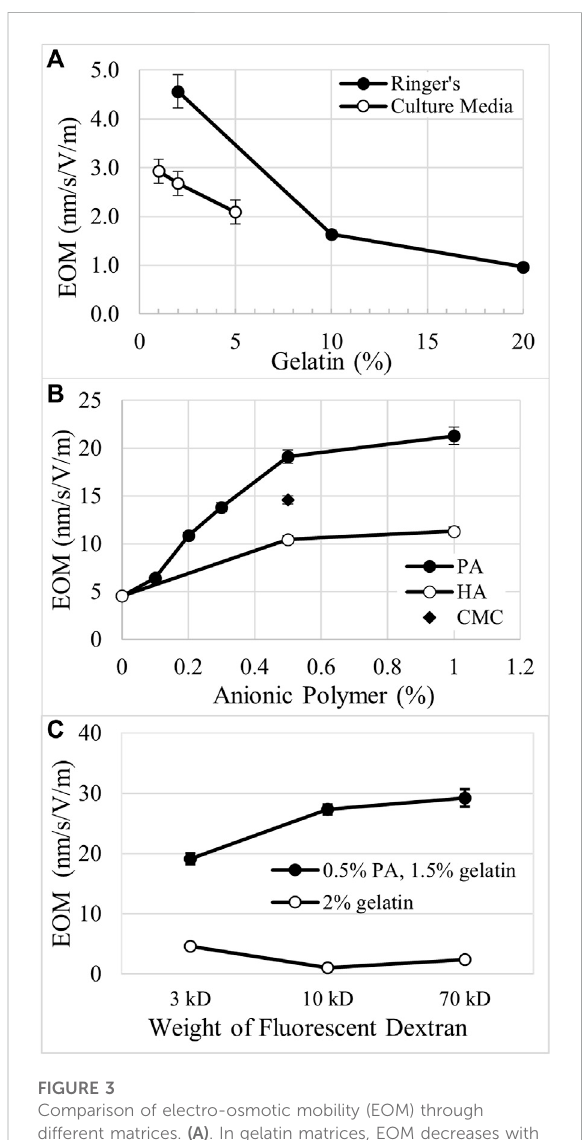
FIGURE 3 Comparison of electro-osmotic mobility (EOM) through different matrices. (A) . In gelatin matrices, EOM decreases with increasing concentration of gelatin when surrounded by either modi fi ed Ringer ’ s or culture media. (B) . Anionic polymers like polyacrylate (PA), hyaluronate (HA), and carboxymethyl cellulose (CMC) increaseEOM in a concentration-dependent manner when mixed with gelatin. 2% was the total combined weight percent of the gelatin-polymer mixtures. (C) . EOM decreases for higher molecular weight dextrans in 2% gelatin, while EOM increases for the larger dextrans in 1.5%:0.5%,